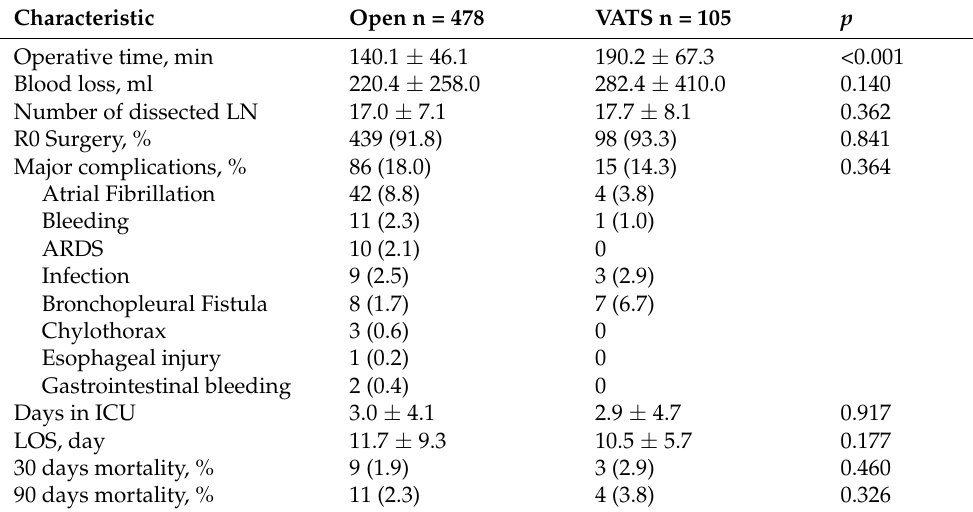
Table 1. Perioperative outcomes between Open and VATS pneumonectomy group patients before propensity-score matching.